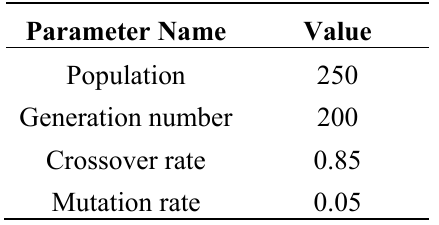
Table 2. Values of GA operators